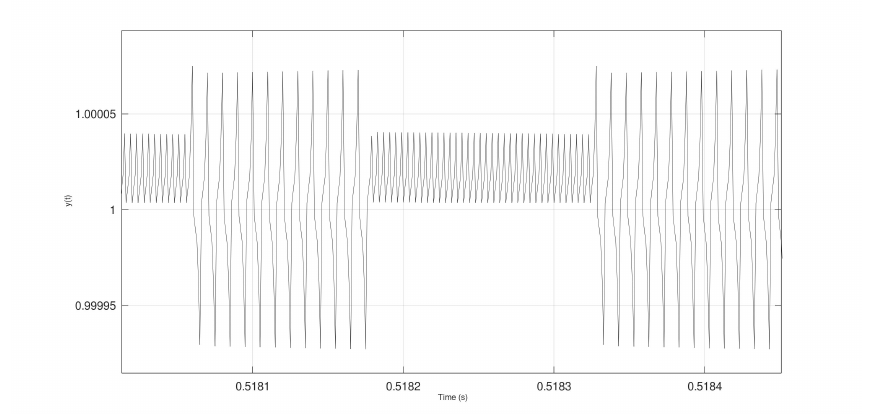
Figure 10. Zoom of the Figure 6 with